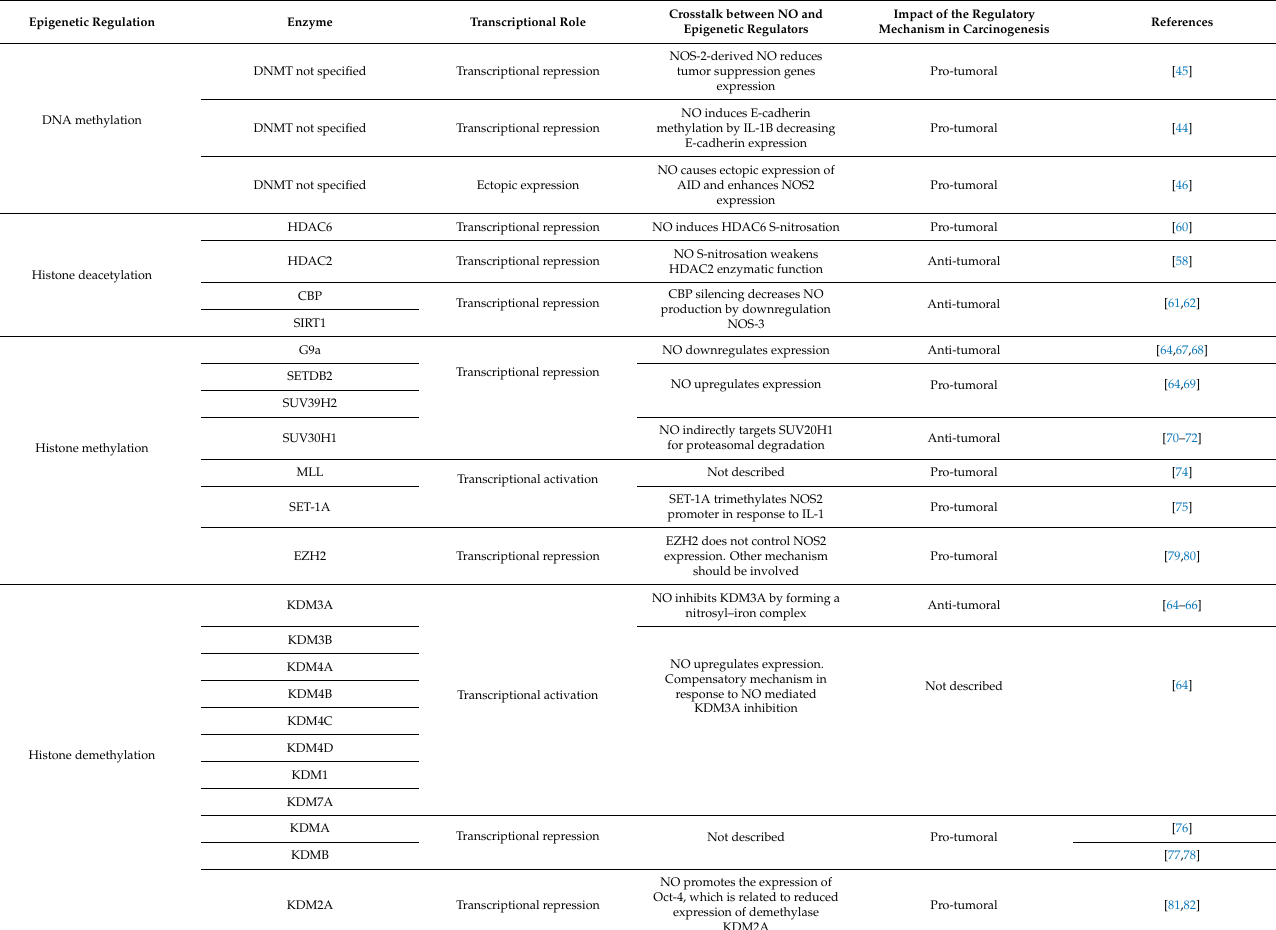
Table 1. Crosstalk between NO and DNA methyltransferases, histone deacetylases, histone methyltransferases and histone demethylases. The table indicates the names of the enzyme involved and its substrate. It summarizes the connections between epigenetic regulators and NO and the impact in cancer.